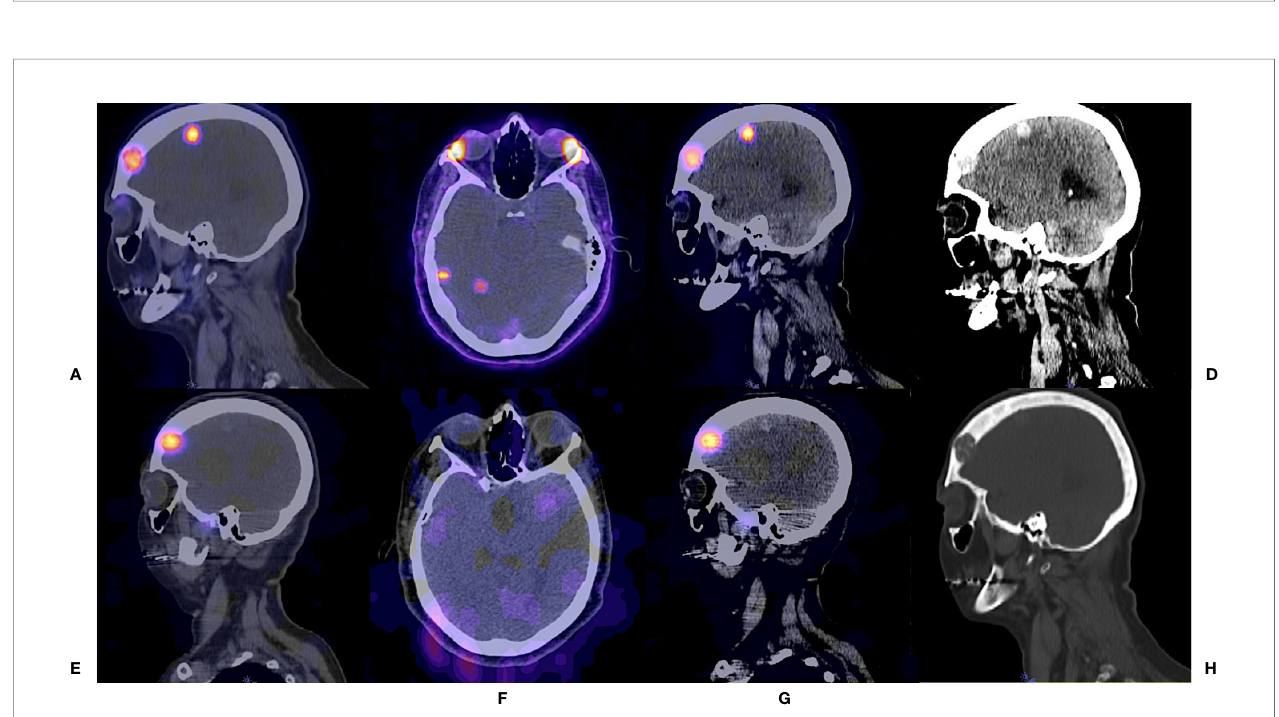
FIGURE 5 | 52 years female, papillary thyroid carcinoma classic variant. Thyroglobulin 1000; radioiodine cumulative dose 7400 MBq. Fused hybrid and simple CT head and neck images. (A – C) show 68 Ga – PSMA PET/CT sagittal (A, C) and axial (B) views in soft tissue (A, B) and brain windows (C) ; while (E – G) demonstrate 131 I – SPECT/CT images in homologous reconstructions. Notice how PSMA PET/CT illustrates more intraparenchymal metastatic lesions, which also show higher tracer uptake than 131 — SPECT/CT. It also can be visualize a bone lytic lesio ́ n in frontal bone. Images on the right represent simple CT sagittal recontructions in brain (D) and bone (H) windows, where morphologic aspects of the lesions are better